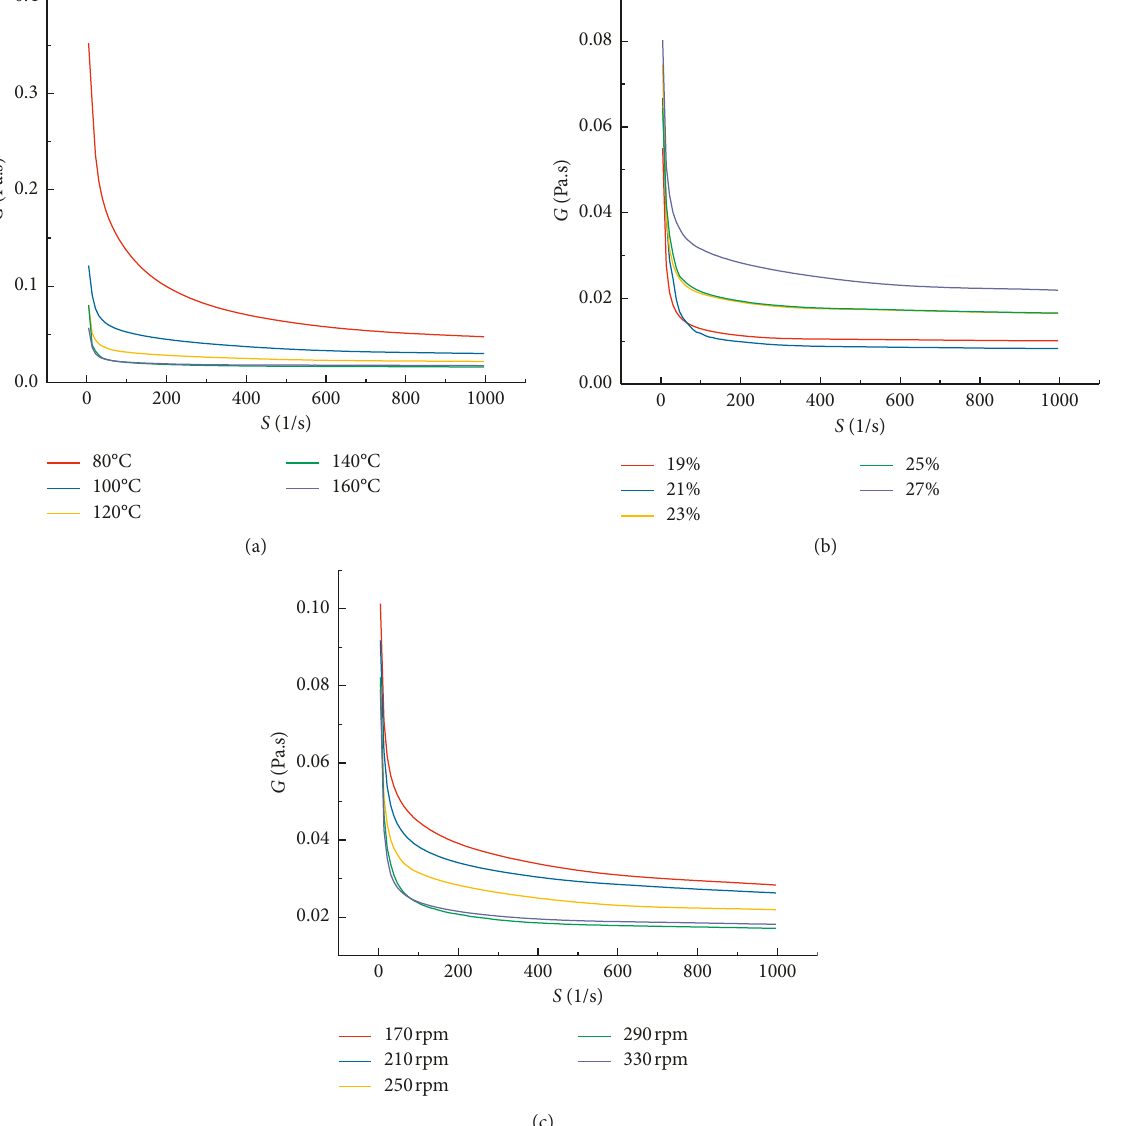
Figure 4: Steady shear viscosity of adlay flours treated by extrusion at different extrusion conditions. (a) Barrel temperature, (b) moisture content, and (c) screw